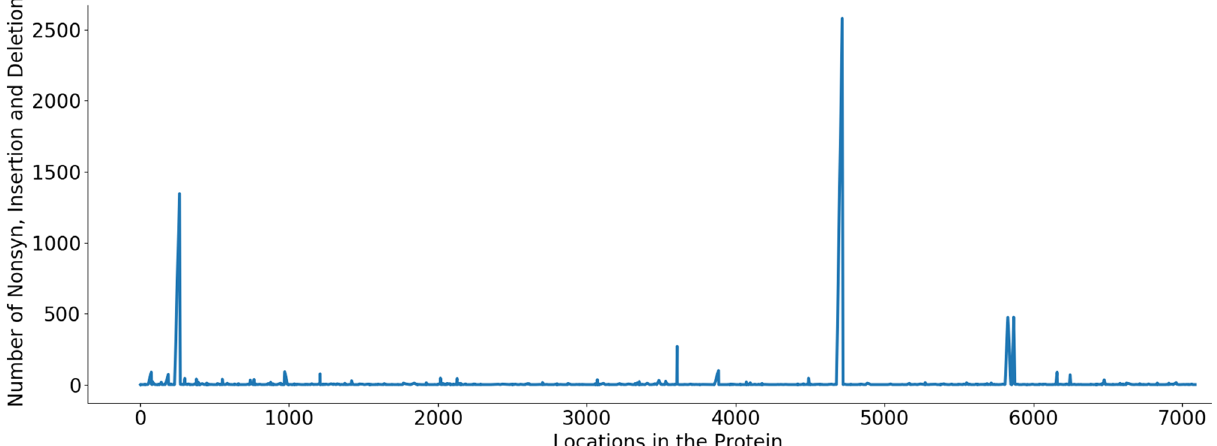
Figure 2. Protein ORF1ab—The number of insertion, deletion and nonsynonymous mutations at different locations in the protein. Spikes at locations: T265I (1344), L3606F (271), P4715L (2576), P5828L (475)